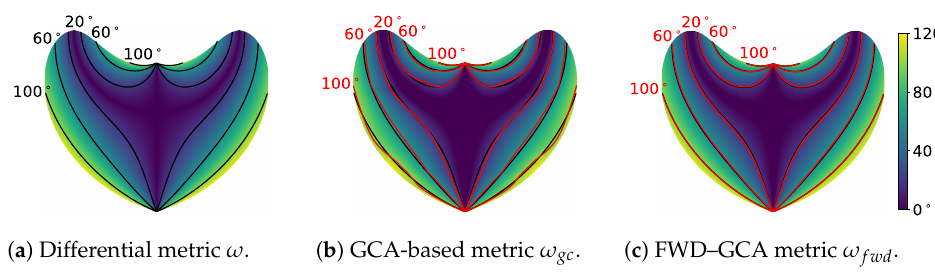
Figure 6. Distribution and contours of the maximum angular distortion for the Bonne projection by linear